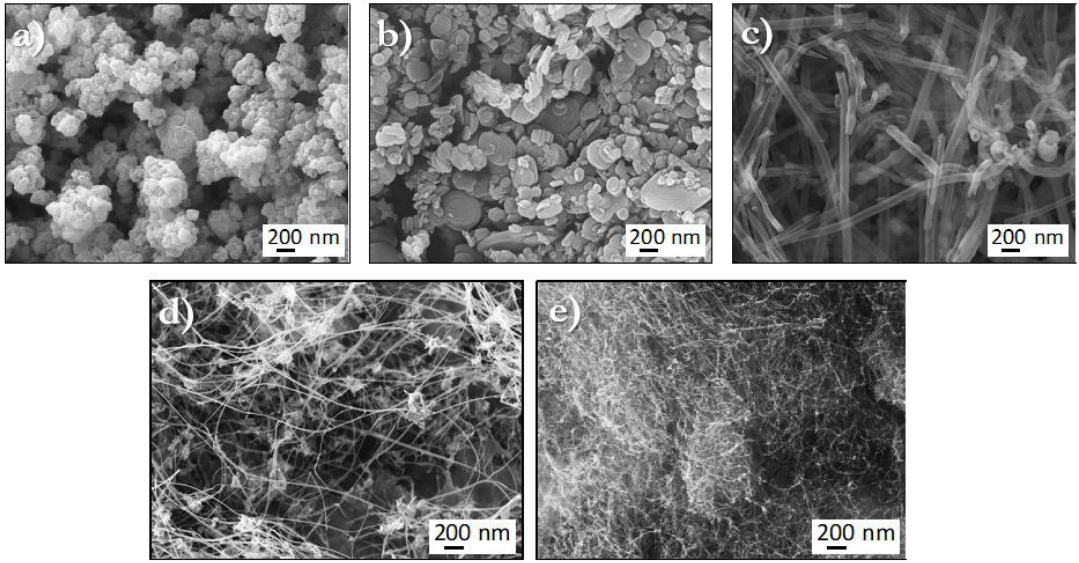
Figure 1 . Representative SEM images of a ) carbopol; b ) boron nitride (BN) particles; c ) carbon Figure 1. Representative SEM images of ( a ) carbopol; ( b ) boron nitride (BN) particles; ( c ) carbon nanofibers (CNFs); d ) boron nitride nanotubes (BNNTs), and e ) carbon nanotubes (CNTs) used for nanofibers (CNFs); ( d ) boron nitride nanotubes (BNNTs), and ( e ) carbon nanotubes (CNTs) used for sample formulation. sample